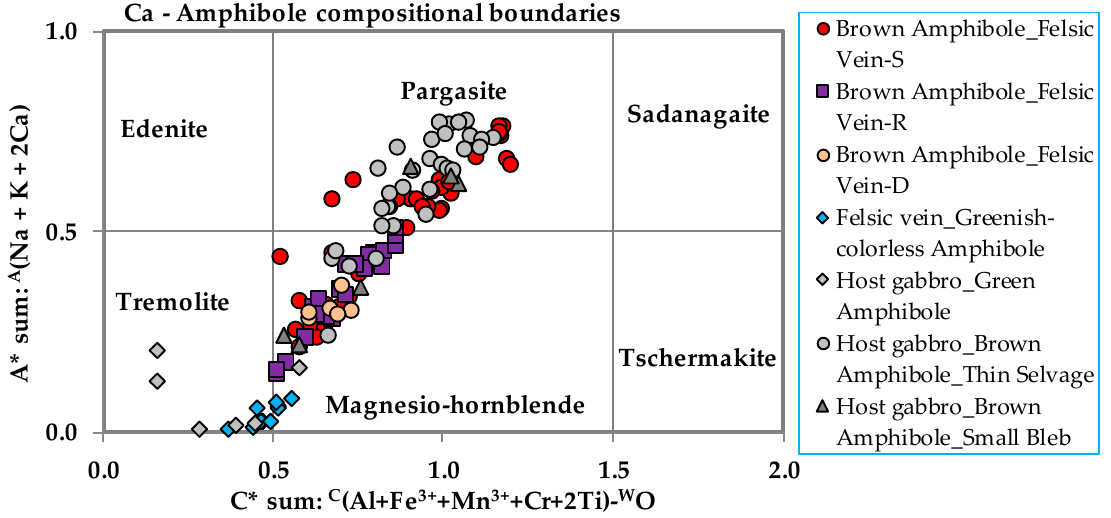
Figure 14. Nomenclature of the amphiboles—Hole U1473A.